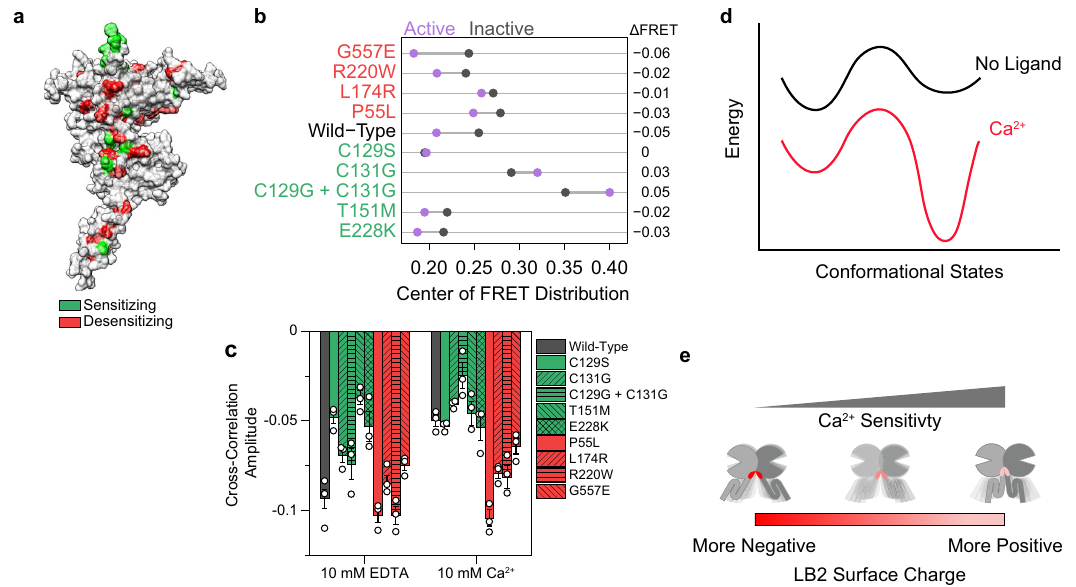
Fig. 8 Changes in CaSR dynamics by mutation predict calcium sensitivity. a Surface representation of CaSR (PDB 5K5T) with known sensitizing (green) and desensitizing (red) mutations mapped to the structure. b Barbell plot showing the center of the FRET distribution in the inactive condition (10 mM EDTA, gray) and active condition (10 mM Ca 2 + + 5 mM L -Trp, purple) for CaSR mutants. Mutants that desensitize (red) or sensitize the receptor (green) are grouped together. The amplitude of the FRET shift is shown on the right. c Amplitude of receptor cross correlation of wild-type (gray), sensitizing (green) mutations, and desensitizing (red) mutations in the presence of 10 mM EDTA or 10 mM Ca 2 + . Data represent mean ± s.e.m. of n = 3 independent biological replicates. d schematic conformational energy landscape of CaSR in the absence of ligand (black) and in the presence of Ca 2 + (red). e Model of CaSR illustrating how the LB2 surface charge modulates sensitivity. As the LB2 becomes more positive, the stability of the active interface increases resulting in increased receptor